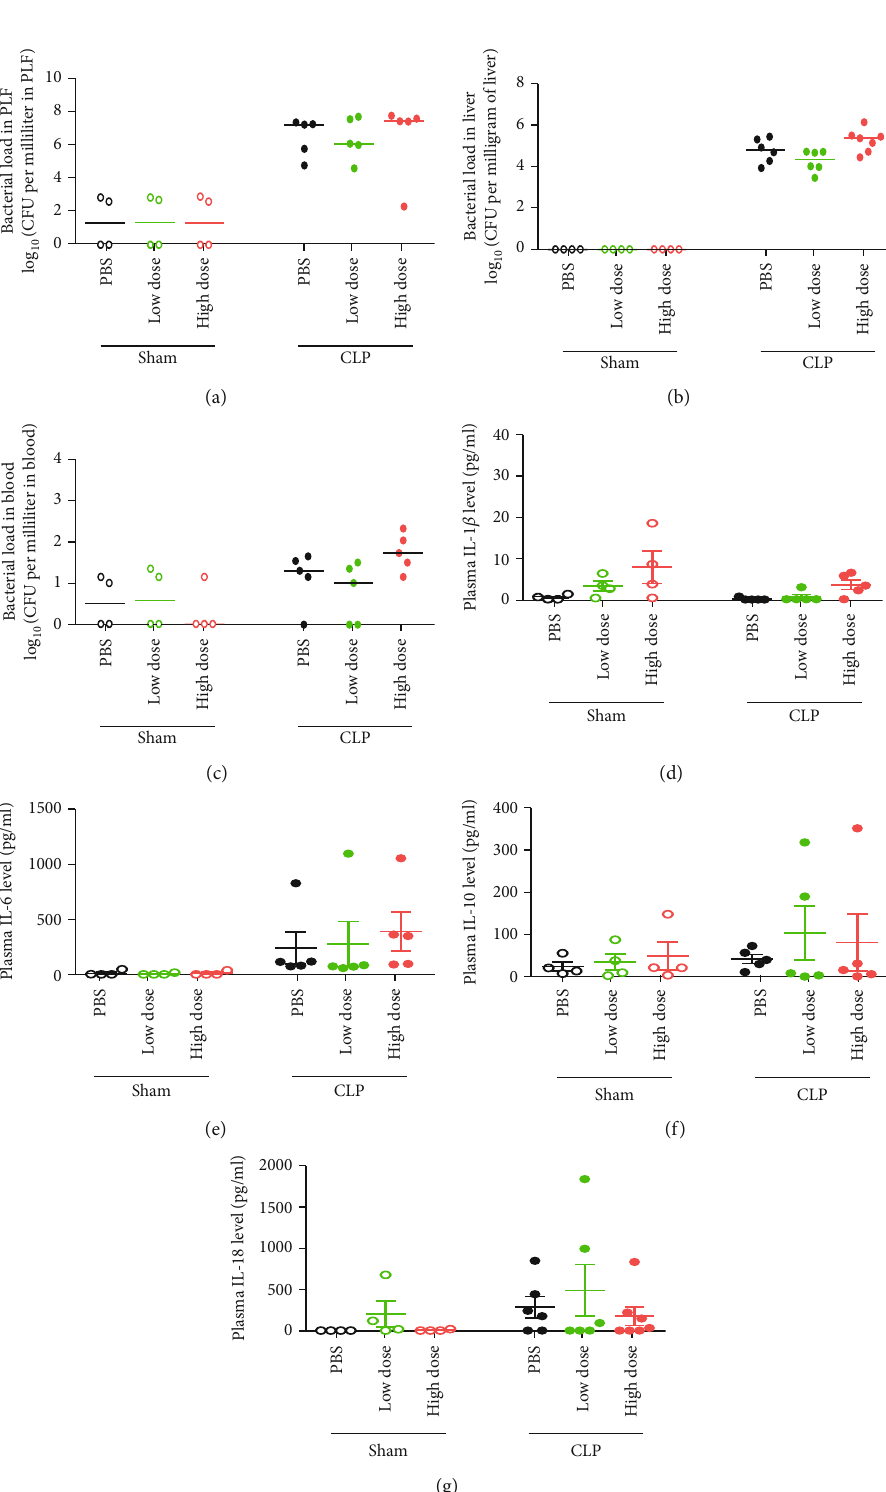
Figure 2: Characterization of bacterial load and in fl ammatory response during sepsis progression. Wild-type mice were intraperitoneally administered a high dose of HNP-1 (10 mg/kg body weight), a low dose of HNP-1 (0.5 mg/kg body weight), or PBS 6 hours after CLP or sham operation. (a – c) Bacterial load in the peritoneal lavage fl uid (PLF; (a)), liver (b), and peripheral blood (c) at 48 hours after CLP or sham operation. The results shown are the medians of 5-7 mice in each CLP group and 4 mice in each sham-operated group. (d – g) Plasma levels of the in fl ammatory mediators IL-1 β (d), IL-6 (e), IL-10 (f), and IL-18 (g) at 48 hours after CLP or sham operation. The results shown are the means ± SEMs of 5-7 mice in each CLP group and 4 mice in each sham-operated